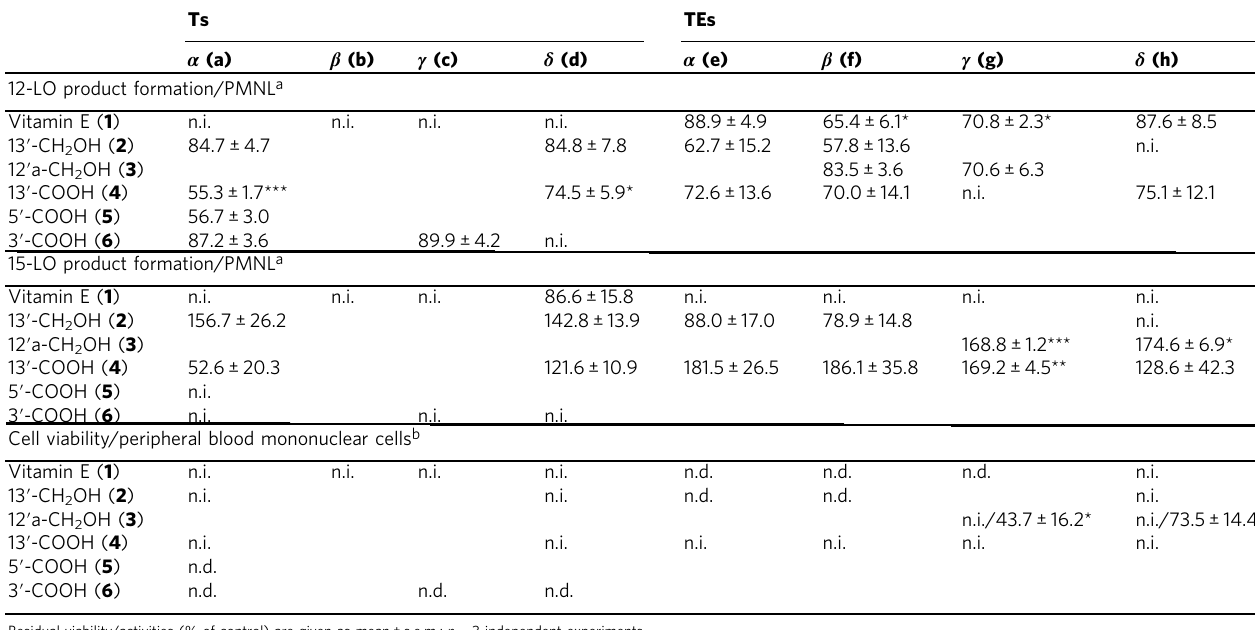
Table 3 Effects of vitamin E derivatives on 12- and 15-LO product formation in PMNL and on cell viability of